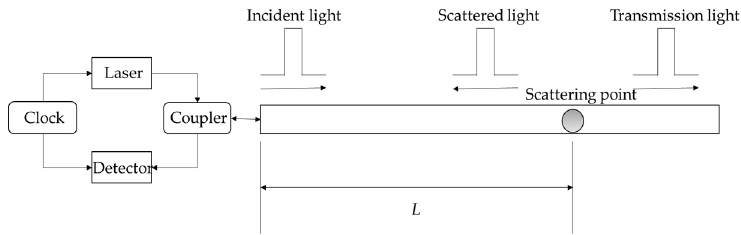
Figure 2. Optical time domain reflection (OTDR) working principle.